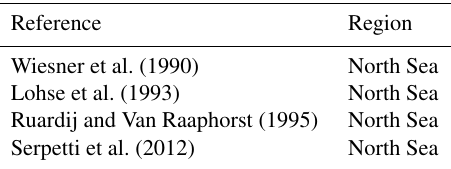
Table 4. Published literature with porosity estimates. These data were used to statistically model porosity in terms of whole-sediment median grain